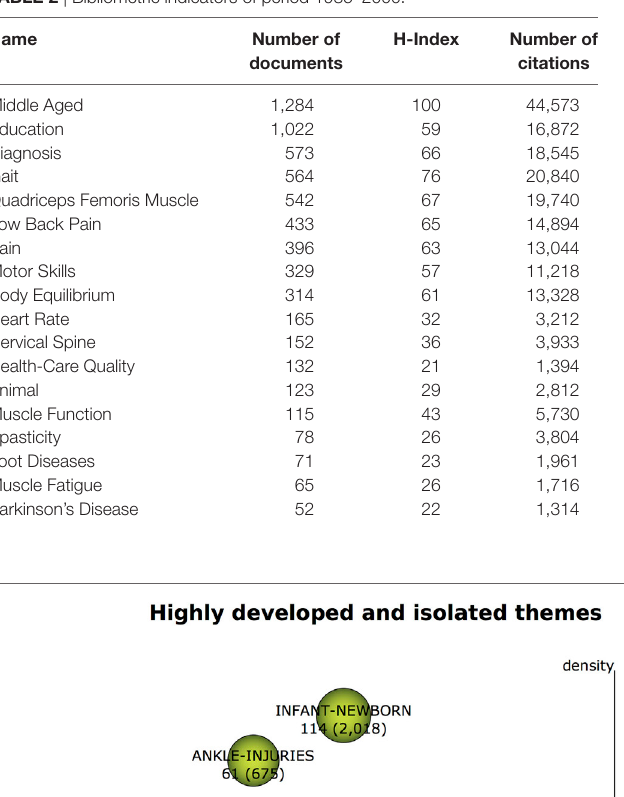
Table 2 | Bibliometric indicators of period